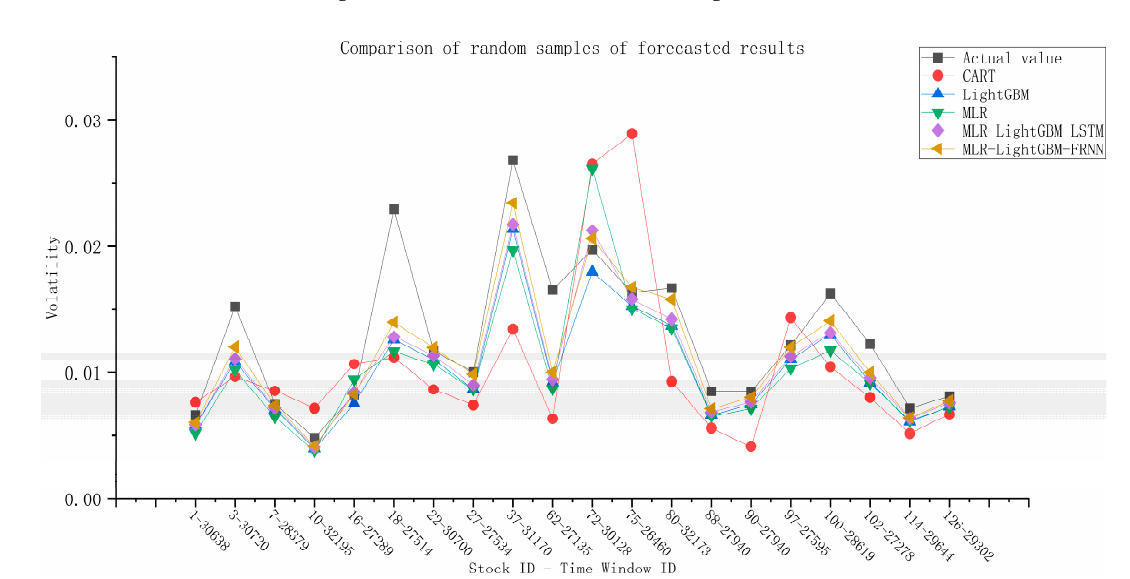
Figure 18. Comparison of prediction results for the test set.